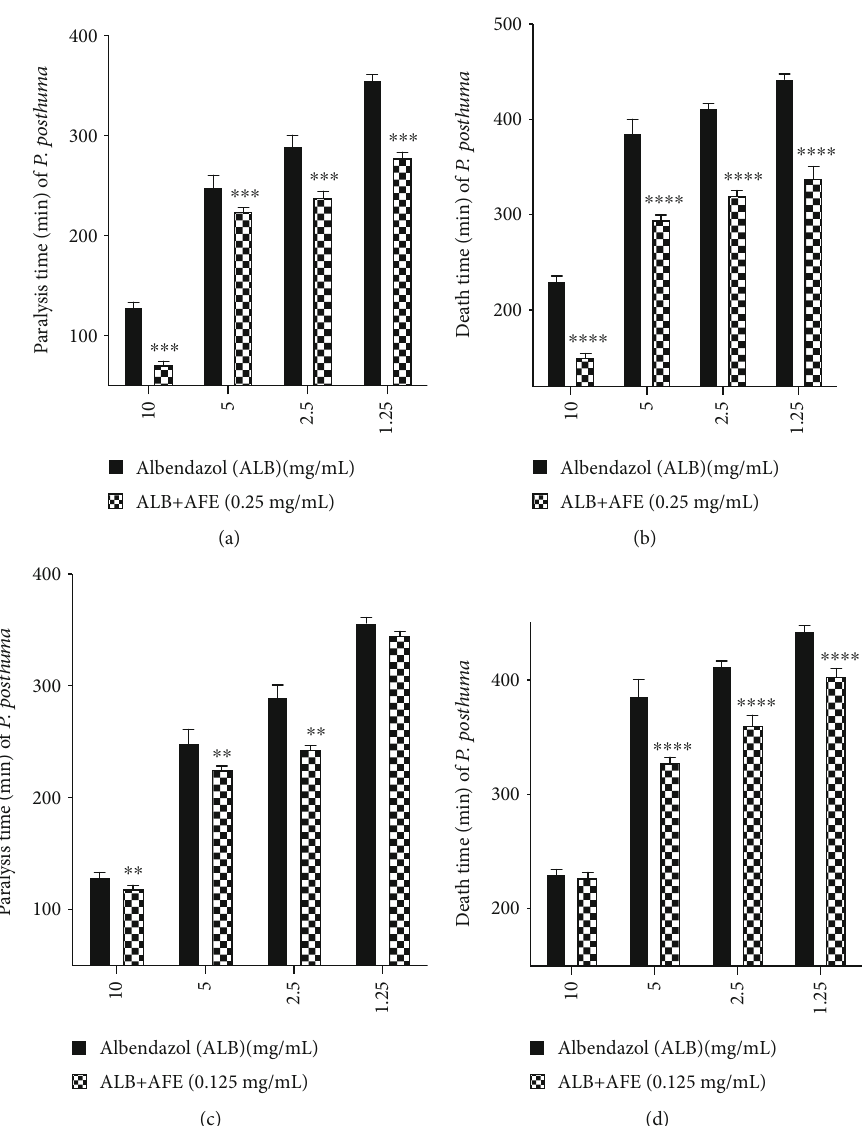
Figure 3: E ff ect of AFE on paralytic and helminthicidal activity of albendazole. (a, b) E ff ect of 0.25mg/mL AFE on albendazole. (c, d) E ff ect of 0.125 mg/mL AFE on albendazole. ALB: albendazole; AFE: A. ferruginea ethanol stem bark extract; ∗∗∗∗ p < 0 : 0001 , ∗∗∗ p < 0 : 001 , and ∗∗ p < 0 : 01 compared to control (one-way ANOVA followed by Dunnett ’ s post hoc